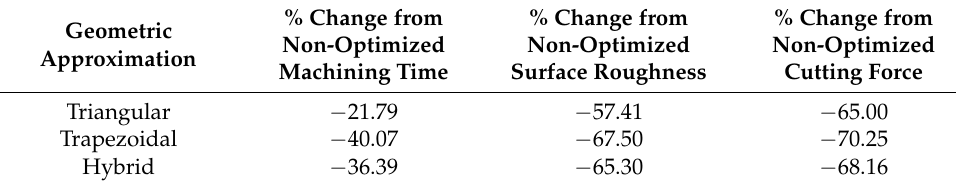
Table 6. Surface roughness objective prioritization